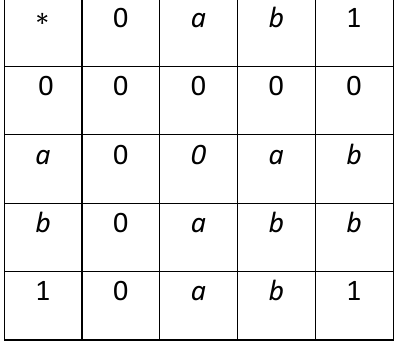
Table3.1: ‘ ∗ ′ Operator